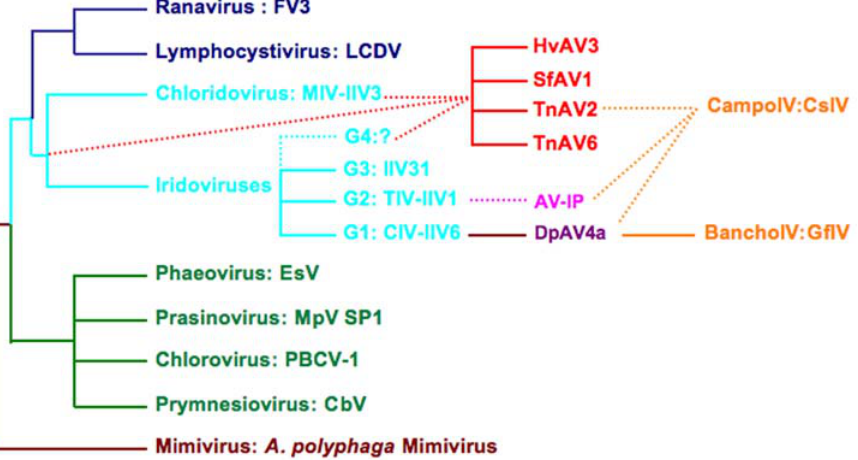
Figure 3. Synthesis of the evolutionary relationships among various genera of Mimiviridae (brown), Phycodnaviridae (green), Iridoviridae (invertebrate genera are in blue and vertebrate genera in dark blue), Ascoviridae (red), DpAV4a (purple) and ichnoviruses, Polydnaviridae (orange). The name of the principal virus representative of each genus is indicated. A putative family of ascovirus- like particles (AV-lP) are in pink. This synthetic tree was determined from results obtained with the evolutionary analyses of the 28 core genes and the literature [9,29,32]. Plain lines represent verified relationships. Dotted lines indicate evolutionary pathways between virus families that require further support for confirmation. Phylogenetic analyses of major capsid protein (MCP) sequences revealed that at least 3 groups (G1, G2, G3) occurred within the iridovirus genus. A hypothetical fourth one, G4, was used to support the putative origin of the Ascoviridae . Taxonomic details and full virus names in each virus family are available at: http://gicc.univ-tours.fr/collaborations/col_pics.php?connect=0&lang=fr or http://www.ncbi.nlm.nih.gov/ ICTVdb/Ictv/fs_ascov.htm; http://www.ncbi.nlm.nih.gov/ICTVdb/Ictv/fs_irido.htm; http://www.ncbi.nlm.nih.gov/ICTVdb/ICTVdB/00.051.0.04.htm; http://www.ncbi.nlm.nih.gov/ICTVdb/Ictv/fs_mimiv.htm; http://www.ncbi.nlm.nih.gov/ICTVdb/Ictv/fs_asfar.htm; http://www.ncbi.nlm.nih.gov/ ICTVdb/Ictv/fs_polyd.htm.